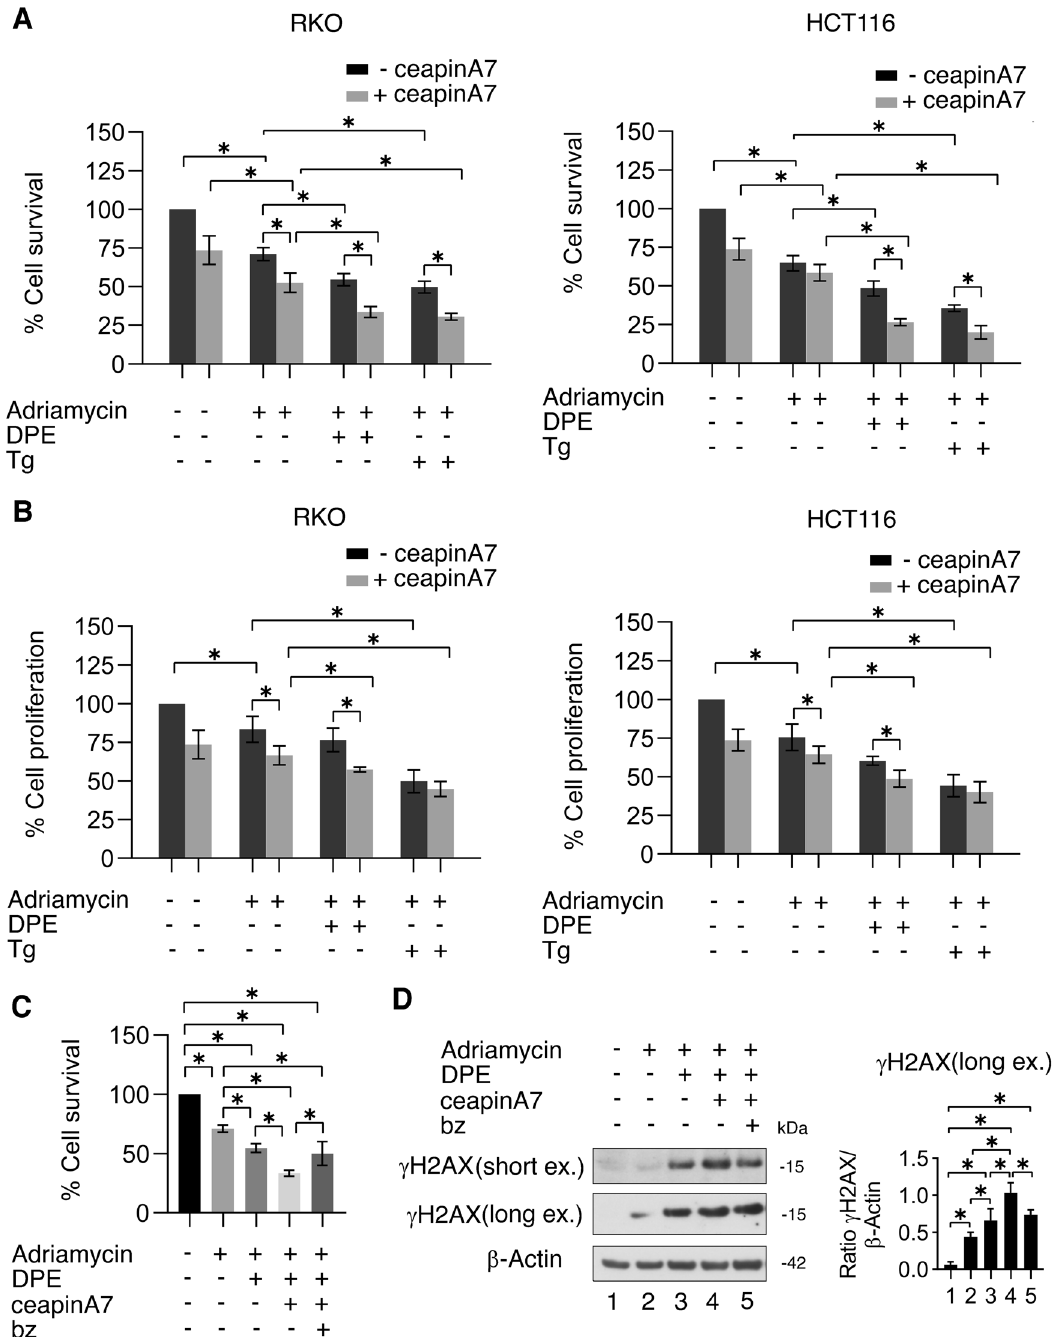
Fig. 6 ATF6 inhibition enhances Adriamycin-mediated reduction of cell survival and cell proliferation in cells treated with DPE or Thapsigargin. RKO and HCT116 cells were pre-treated or not with ceapinA7 (12 μ M) for 1 h and then treated or not with DPE (100 μ M) or Thapsigargin (Tg) (30 nM) or left untreated, as control. After 3 h of culture, Adriamycin (1 μ g/ml) was added to the cultures. A Cell viability was measured by a Trypan Blue exclusion assay after 48 h of culture, the histograms represent the mean ± S.D. of live cells as percent of untreated control cells. p value: *< 0.05. By using the KERN index (R), we found that ceapinA7 induced a synergistic cytotoxic effect in combination with DPE/Adriamycin in both RKO and HCT116 (R > 1) and in combination with Thapsigargin/Adriamicin in HCT116 cells (R > 1) while in RKO cells ceapinA7 combined with Thapsigargin/Adriamicin induced an additive effect (R = 1). B Cell proliferation was measured by MTT assay after 48 h of culture, the histograms represent the mean ± S.D. of the ratio between the OD of treated cells and control cells. p value: *< 0.05. C RKO cells were pre-treated or not with ceapinA7 (12 μ M) for 1 h and then treated or not with DPE (100 μ M). After 3 h of culture, Adriamycin (1 μ g/ml) was added to the cultures. Proteasome inhibitor bortezomib (bz) was added to the cultures for the last 6 h of treatments. Untread cells were used as control. Cell viability was measured by a Trypan Blue exclusion assay after 48 h of culture, the histograms represent the mean ± S.D. of live cells as percent of untreated control cells. p value: *< 0.05. D Protein expression level of γ H2AX was evaluated by western blot analysis. β -Actin was used as loading control. The histograms represent the densitometric analysis of the ratio of γ H2AX/ β -Actin of three different experiments. Data are represented as the mean plus S.D. * p -value < 0.05.